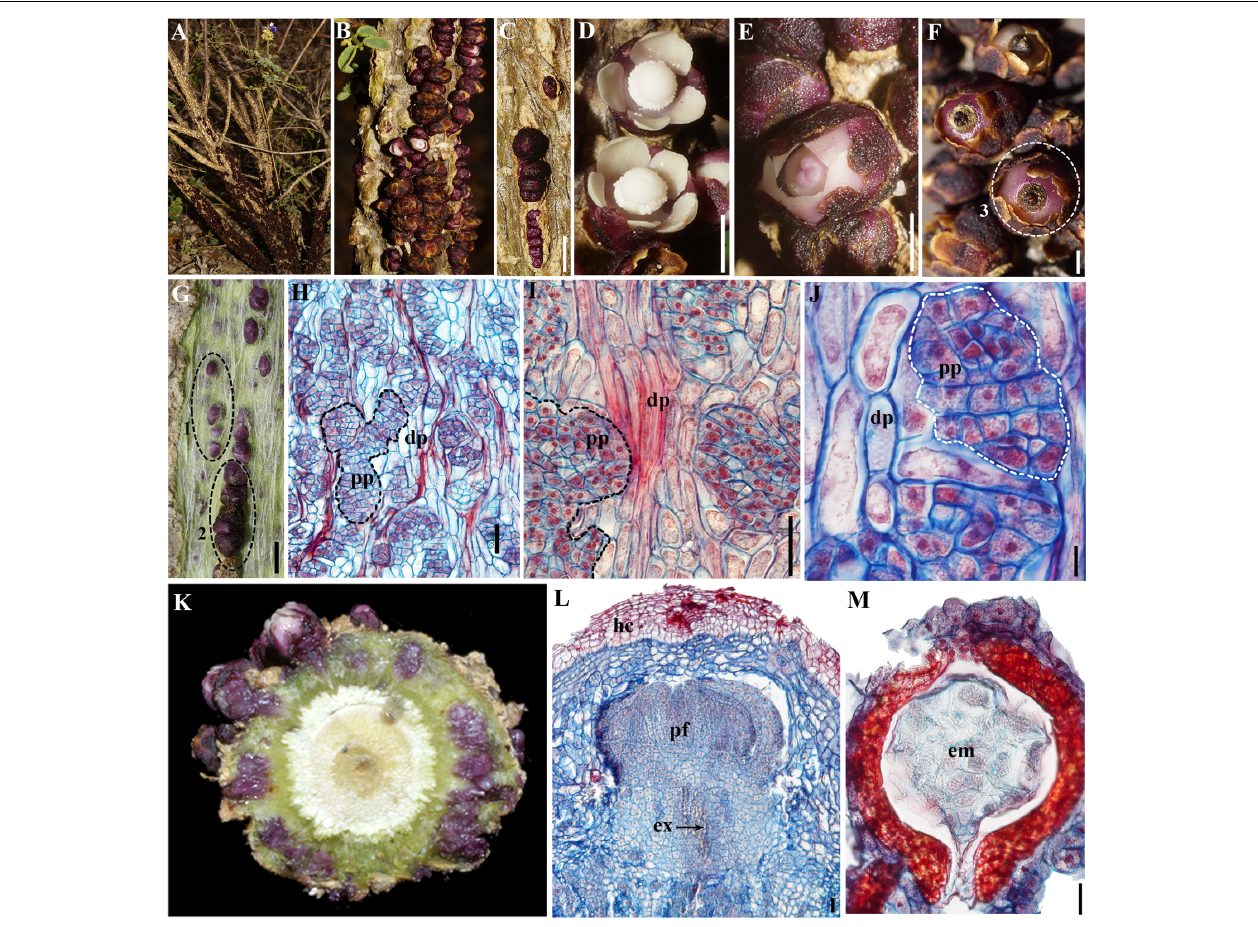
FIGURE 1 | (A–F) Pilostyles boyacensis exophyte; (A–C) overall view; (A) detail of flowers; (B,C) flowers emerging from its host Dalea cuatrecasasii . (D) Staminate flowers; (E) carpellate flowers; (F) fruits; (G) Peeled-off stem portion of D. cuatrecasasii showing flowers of P. boyacensis at various stages of development and growth; white fibers correspond to the phloem host tissue. (H–J) Longitudinal section of infected D. cuatrecasasii stem at (H) low; (I) mid and, (J) high magnification showing irregular aggregations of Pilostyles parenchymatic cells (pp, dotted) in contact to host phloem (dp). (K) Transverse section of infected D. cuatrecasasii stem showing flowers of P. boyacensis at various stages of development and growth; (L) Longitudinal section of P. boyacensis floral bud (pf) and its vascular extensor (ex), still inside of the host cortex (hc). (M) Longitudinal section of P. boyacensis seed with embryo (em). Numbers (1–3) in (F) and (G) indicate the three tissues sampled for the transcriptomes, as follows: (1) Dalea / Pilostyles mixed tissue; (2) Preanthetic Pilostyles flowers; (3) Pilostyles fruits and seeds. Scale bars: (C–G) 2 mm; (H,I,L) 100 µ m; (J) 10 µ m; (M) 20 µ